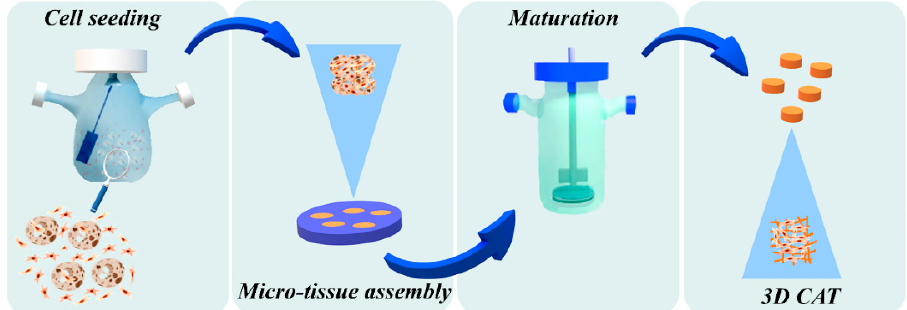
Figure 1. Bio-engineered process to develop the cystic fibrosis (CF) connective airway tissue (CAT): Cystic fibrosis human lung fibroblasts (CF-HLF) were seeded on porous gelatin micro-scaffolds into spinner flasks bioreactor; 18 days after the seeding of the fibroblasts cystic fibrosis micro-tissues (CF-µTPs) were retrieved and assembled into maturation chambers, after 3 weeks it was possible to obtain the final connective airway tissue (CAT), featured by the presence of fibroblasts embedded in their own matrix. The same process, but starting from normal human lung fibroblasts (N-HLF), was used to obtain the normal connective airway tissue (NA-CAT) as experimental control.